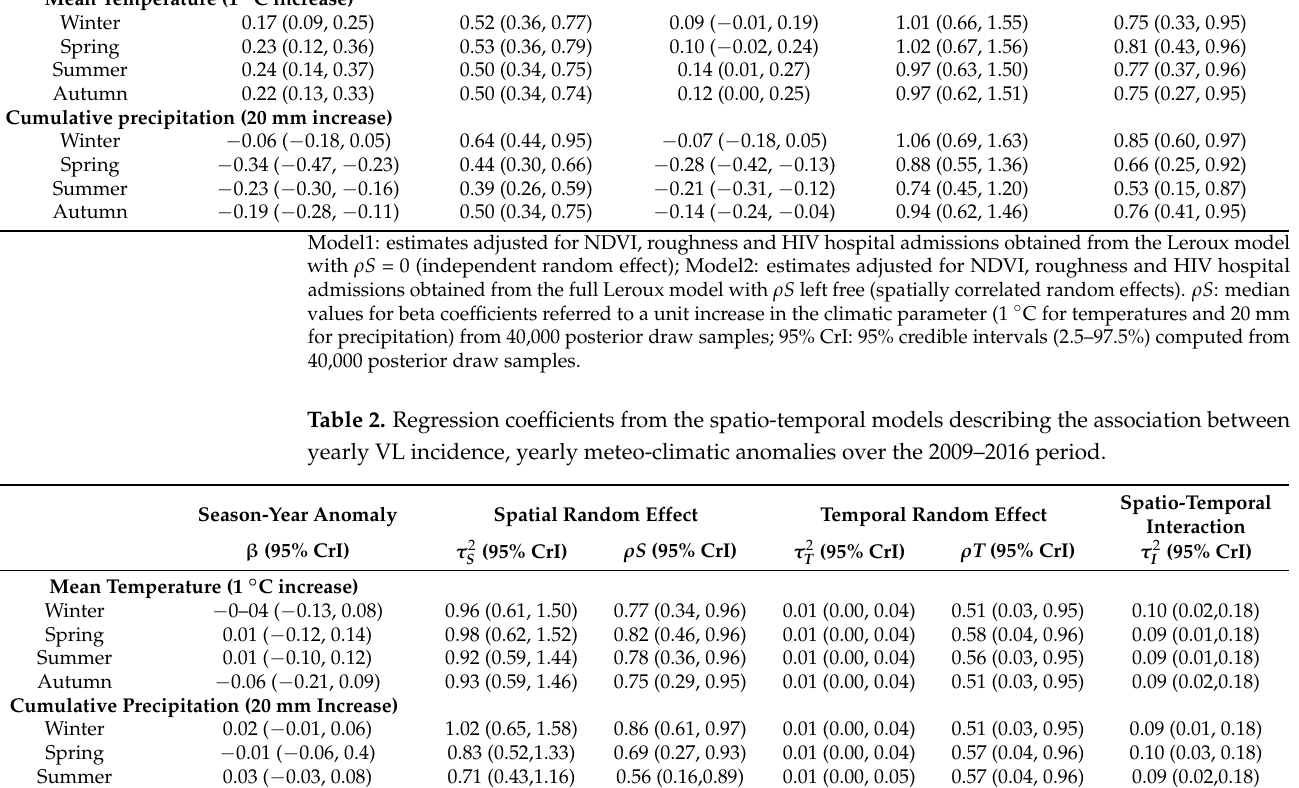
Table 1. Regression coefficients from the spatial models describing the association between the 2009–2016 VL incidence cases and climatic parameters values averaged over the 2009–2016 period. Model 1 Model 2 β (95% CrI)